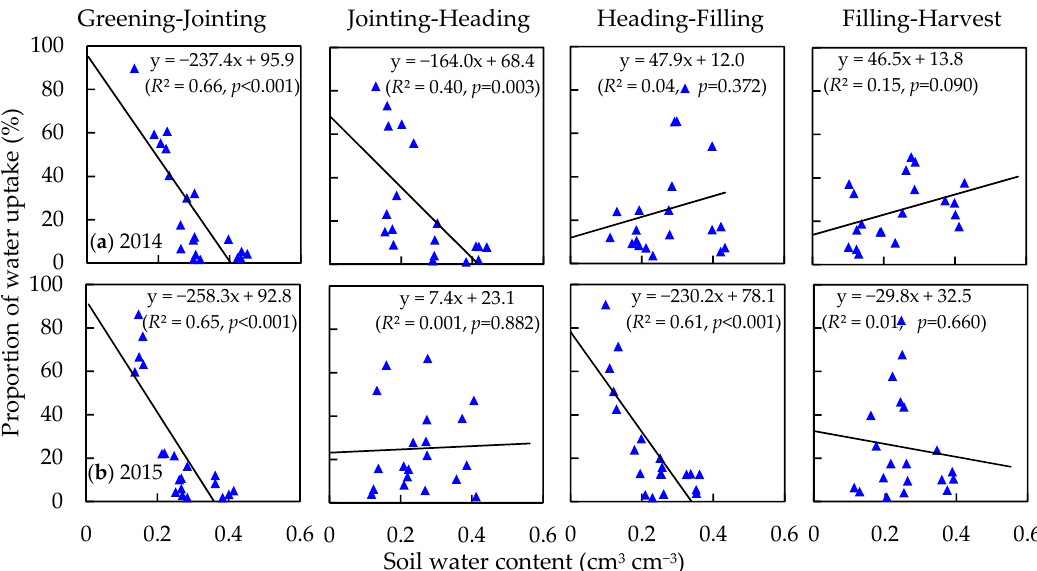
Figure 9. Relationship between water uptake proportion and mean soil water content at each growth stage in the ( a ) 2014 and ( b ) 2015 seasons.